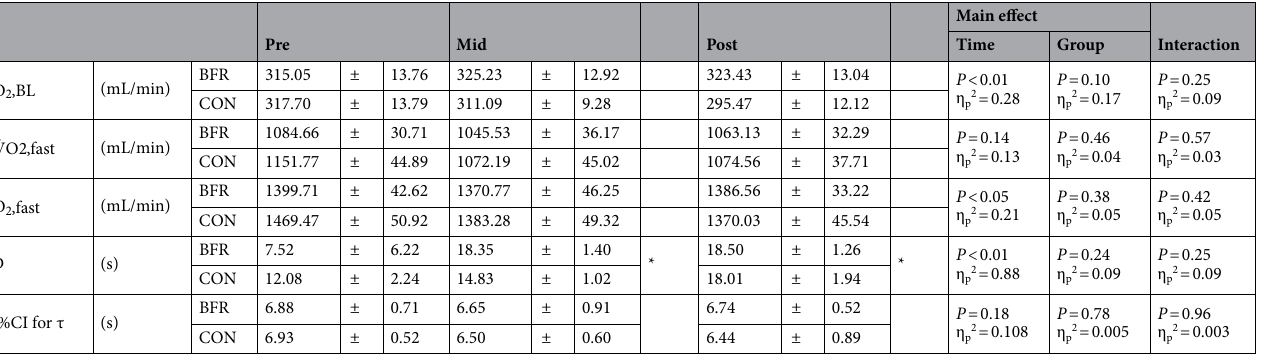
˙ VO Table 1. Oxygen uptake ( 2 ) kinetic parameters during moderate-intensity constant-load exercise before (Pre), 4 weeks after (Mid), and 8 weeks after (Post) cycle training with (BFR group) or without (CON ˙ VO2 ˙ VO ˙ VO group) blood flow restriction (BFR). ,fast, asymptotic amplitude of the fast 2 ,BL, baseline of 2 ; (cid:31) ˙ VO ˙ VO component (the increase in 2 from the baseline to the asymptote of the fast component); 2 ,fast, absolute asymptotic amplitude of the fast component (the sum of the baseline and the asymptotic amplitude); TD, delay time; 95% CI for τ, 95% confidence interval for phase II time constant. Statistical analysis was performed using a repeated-measures two-way analysis of covariance followed by Bonferroni’s multiple comparisons test. Partial eta squared (η p 2 ) is the effect size of the interaction and main effects of group and time. Values are expressed as mean ± SE (n = 9). *Significant difference from pre-training (pre) ( P < 0.05).